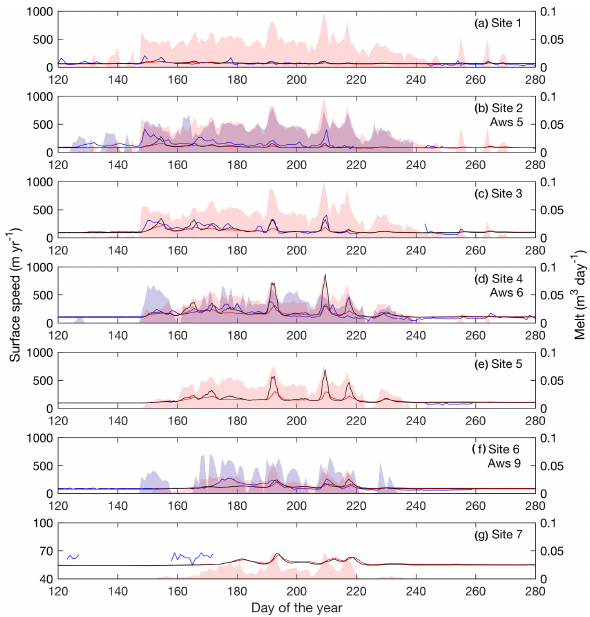
Figure 8. Modelled ice velocities plotted against GPS measure- ments for the 2012 melt season. Daily average horizontal velocity from GPS measurements are plotted in blue. Modelled velocities using the Schoof sliding law and Budd sliding law are plotted in black and red, respectively. Daily ablation from weather stations are shown in shaded blue, while RACMO2.3 surface runoff is shown in shaded red. Locations of GPS and weather station sites are shown Fig. 1. Weather station ablation rates are plotted at the nearest GPS site.